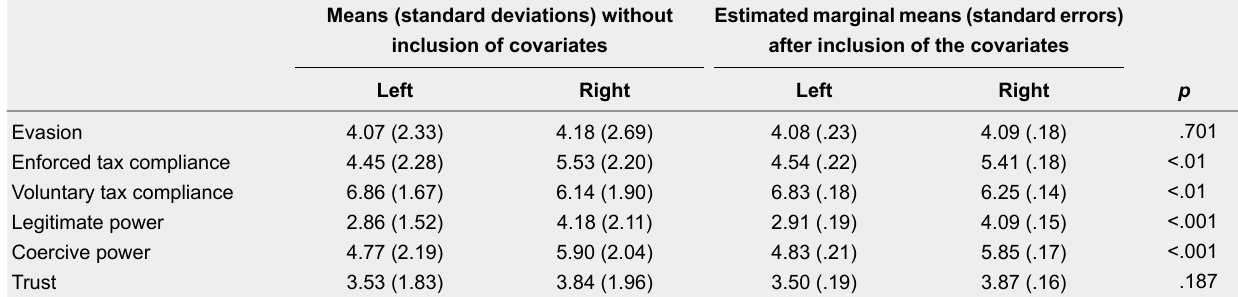
TAX-I Scores for the Two Political-Ideology Groups Estimated marginal means (standard errors) covariatesMeans (standard deviations) without after inclusion of the inclusion of